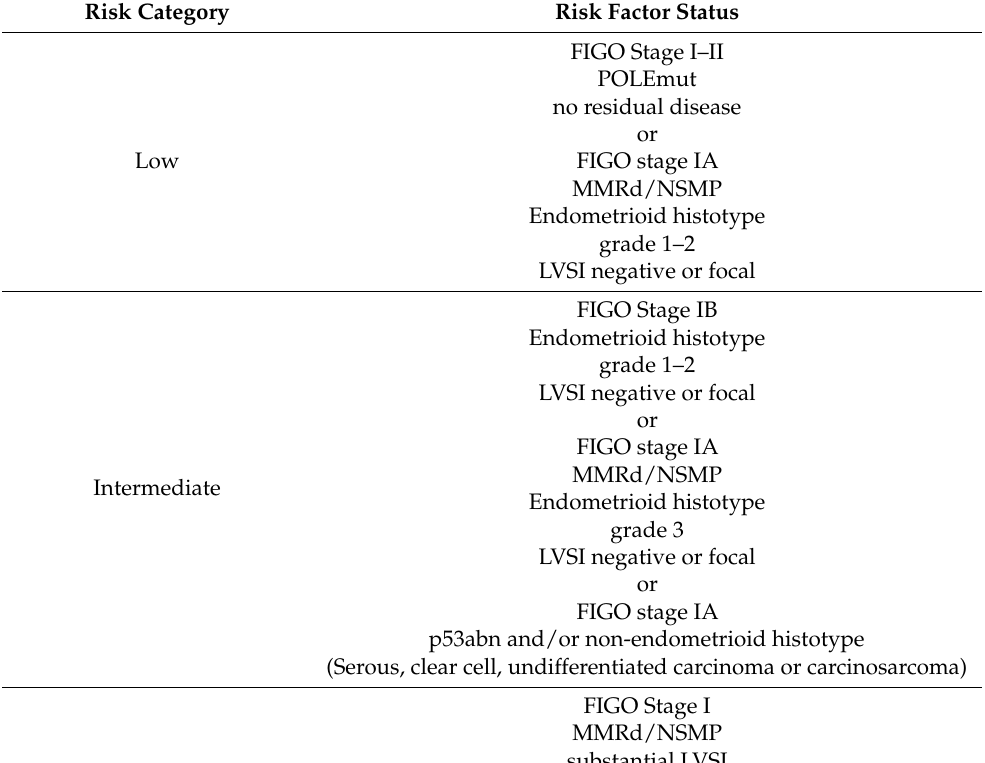
Table 2. Endometrial cancer ESMO/ESGO/ESP classification system, by Concin et al. 2021